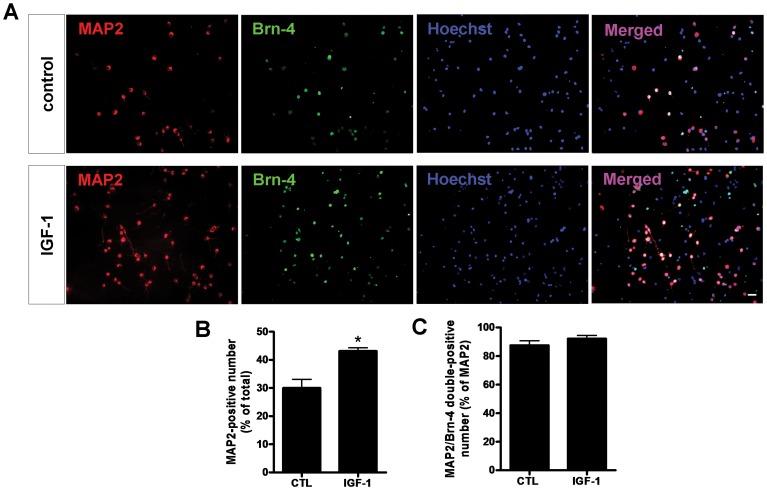
Immunofluorescence analysis of Brn-4 expression and neuronal differentiation (MAP2 expression) of hippocampal NSCs after treatment with (IGF-1) or without (control) 100 ng/ml IGF-1.(A) Cells were stained separately for MAP2, Brn-4 and the total cells were indicated by Hoechst staining. Scale bar, 25 µm. (B) Quantification of MAP2 positive neurons as a percentage of total cells. (C) Quantification of MAP2/Brn-4 double-positive neurons as a percentage of MAP2-positive neurons. Data are means ± s.e.m of 10 randomly selected microscopic fields in each experiment (n = 3). *, P<0.05 versus control.